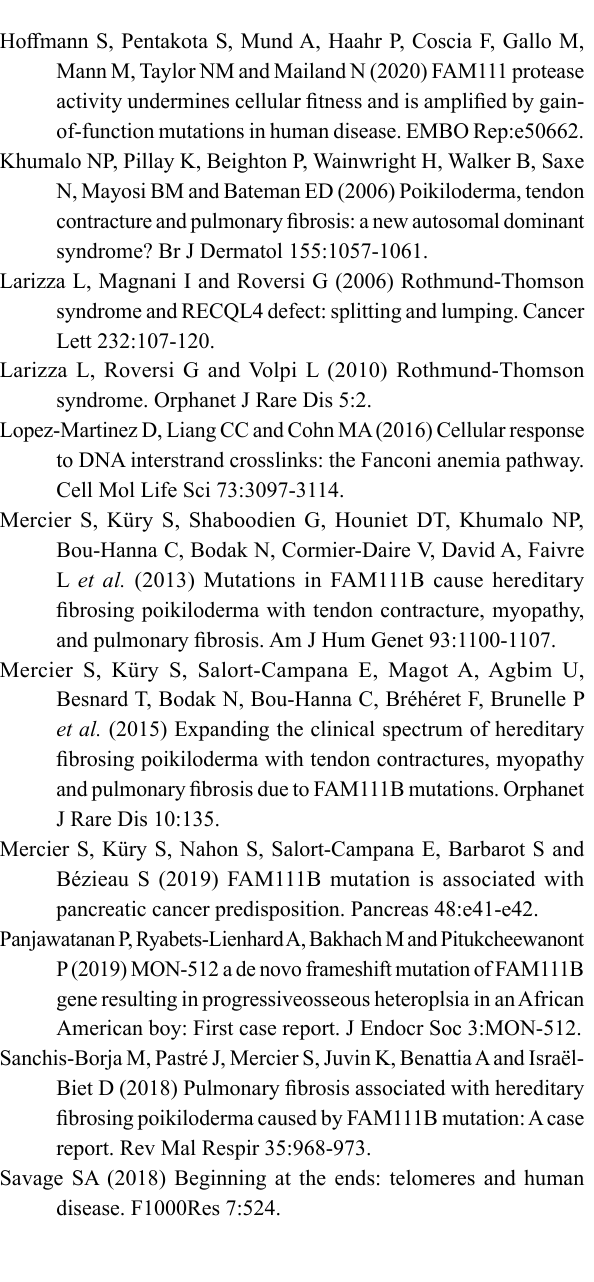
Figure S1 – Common and specific clinical features of POIKTMP, RTS-II, and